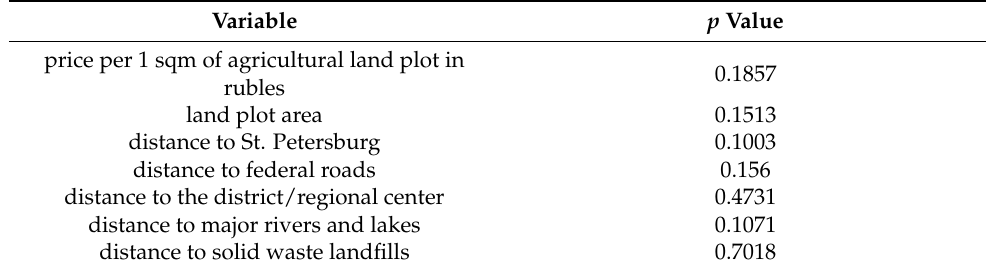
Table 1. p values for Kolmogorov–Smirnov test for